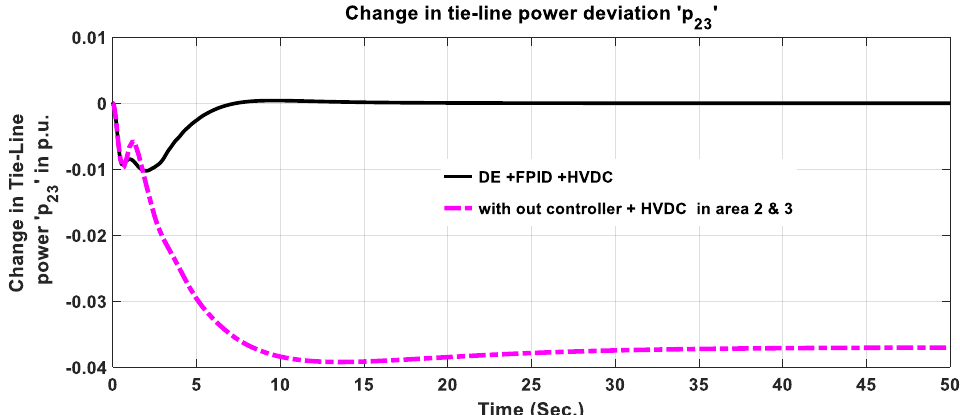
Figure 12. Comparison of controller and without controller + HVDC for change in tie-line power deviation P12.